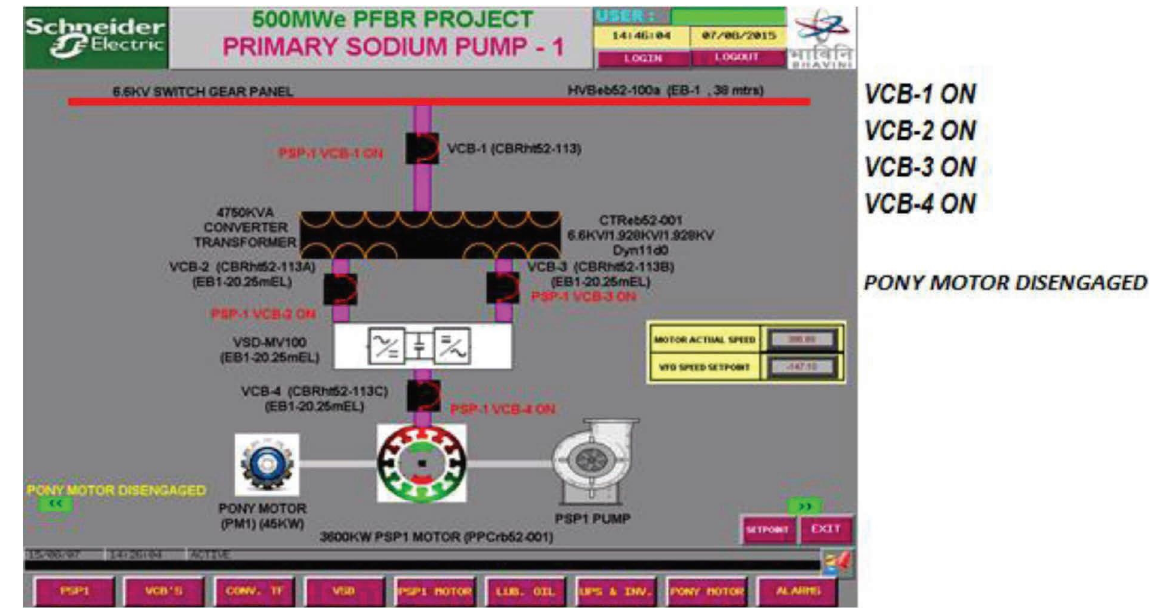
Figure 21: VFD running state screen conditions in the common control panel (CCP).